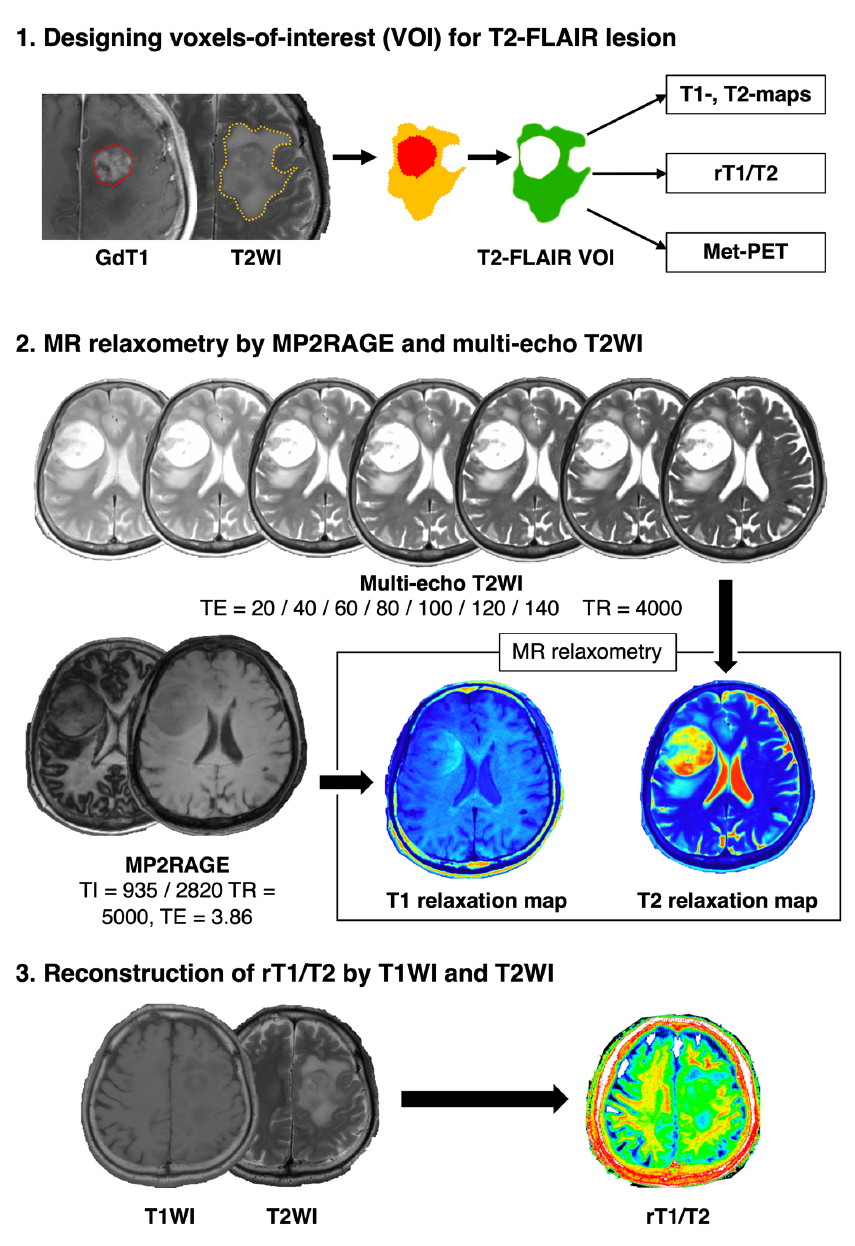
Figure 1. The analytical scheme of this study is presented. VOIs were depicted by subtracting